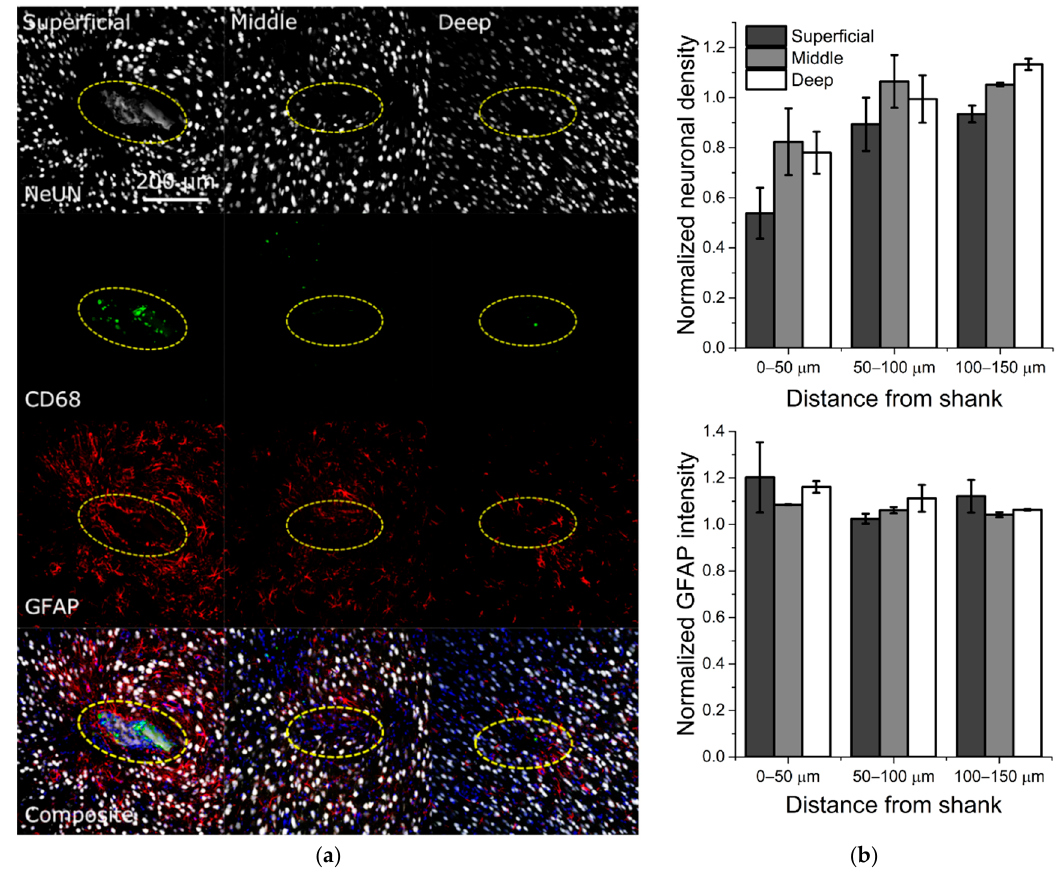
Figure 6. Immunohistochemistry for SMP implant after 13 weeks in vivo. ( a ) Columns represent tissue collected at superficial, middle, and deep slices in relation to the surface of the motor cortex. Rows represent neuronal nuclei (NeUN) (gray, top), activated microglia/macrophages (CD68) (green), astrocytes (GFAP) (red), and Composite (bottom) images. Scale bar represents 200 µm in the transverse plane across all images. Yellow ellipses indicate probe location. ( b ) Quantification of NeuN and GFAP for n = 2 animals at varying slice depths (one slice per region) with respect to the shank location in the brain.